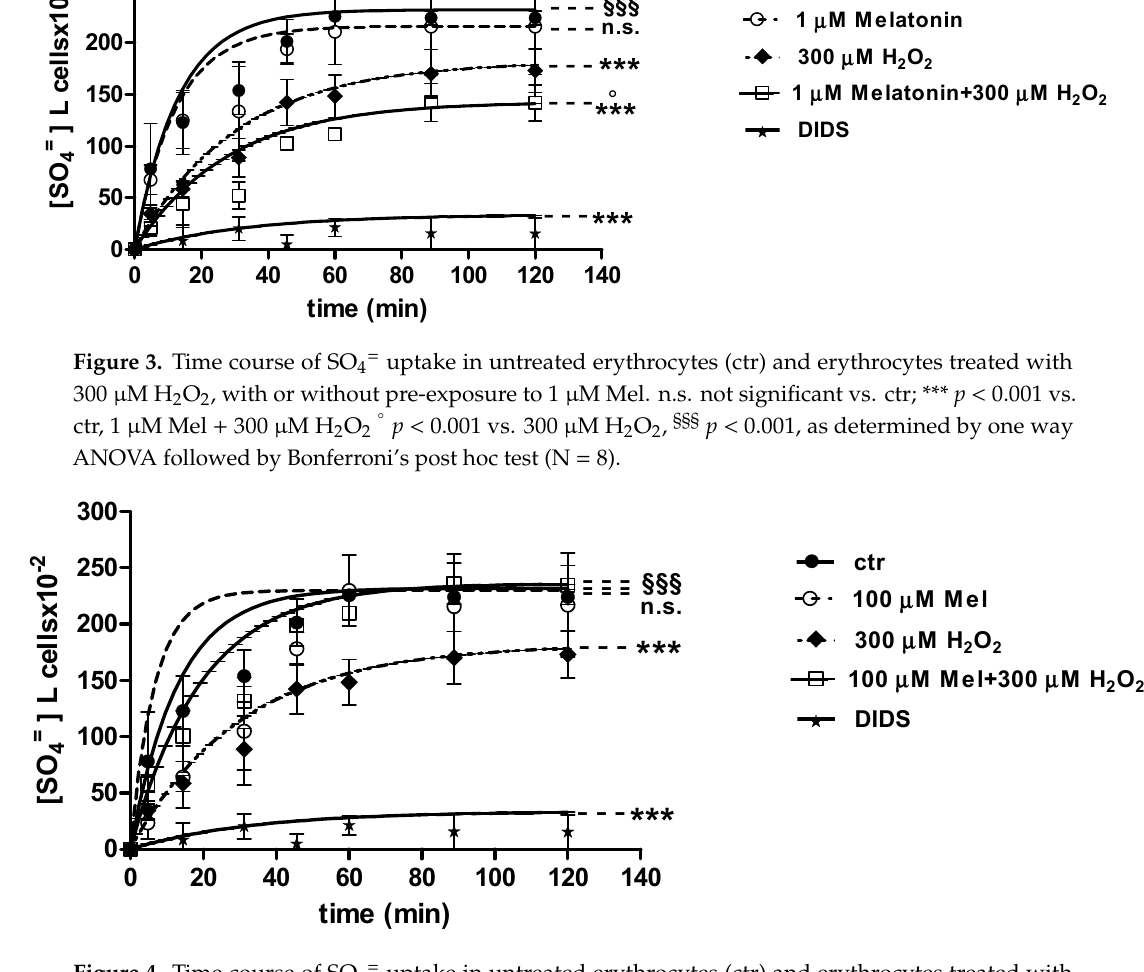
Figure 4. Time course of SO 4= uptake in untreated erythrocytes (ctr) and erythrocytes treated with 300 μ M H 2 O 2 , with or without pre-exposure to 100 μ M Mel. n.s. not significant vs. ctr; *** p < 0.001 vs. ctr, 100 μ M Mel + 300 μ M H 2 O 2 §§§ p <0 .001 vs. 300 μ M H 2 O 2 , as determined by one way ANOVA followed by Bonferroni’s post hoc test (N = 8).